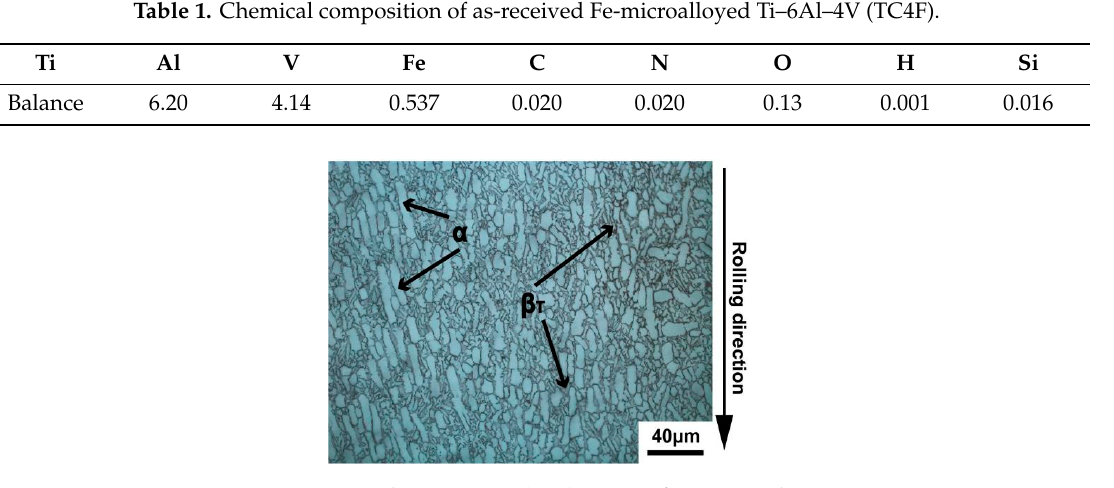
Figure 1. Optical-microscope (OM) image of as-received TC4F.